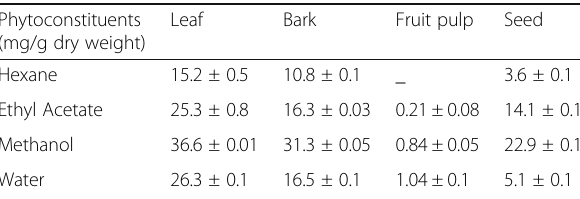
Table 3 The quantitative estimation of total tannin content of the different solvent extracts of S. caryophyllatum leaf, bark